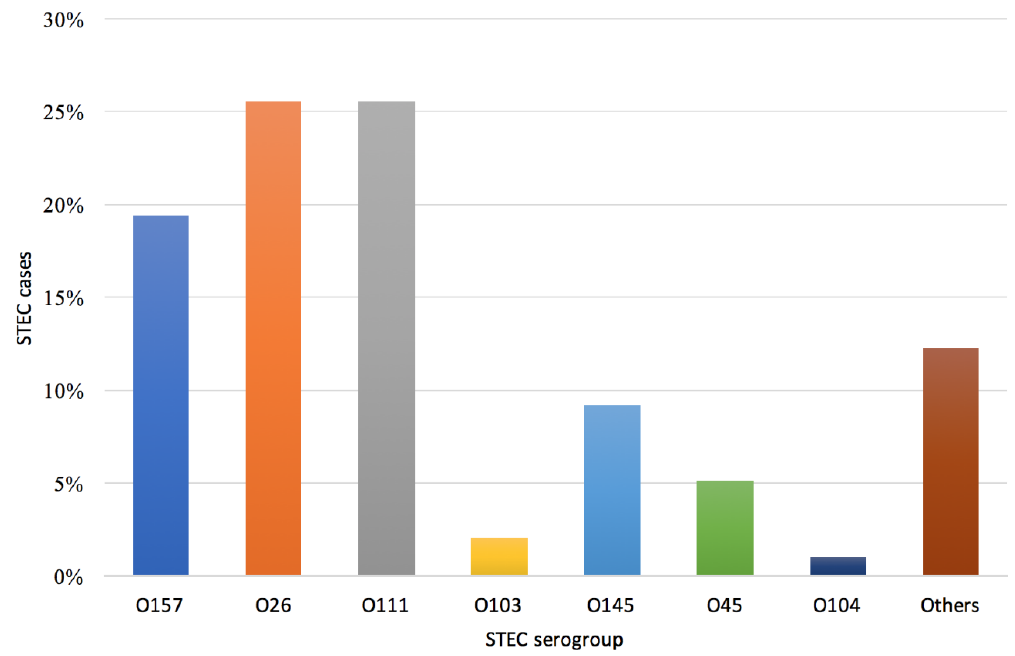
Figure 4. Distribution of STEC serogroups (n = 98) detected in children with bloody diarrhea, Apulia region, June 2018–August 2019.